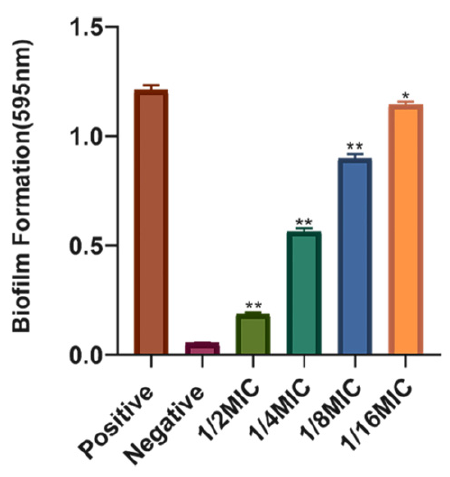
Figure 6. The influence of syringopicroside on Streptococcus suis biofilm formation. The data were expressed as means±SD. ** p < 0.01, * p < 0.05.